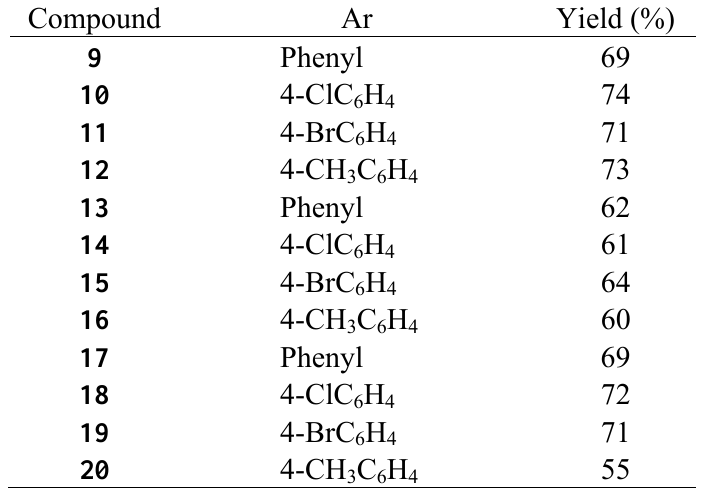
Table 2 . 4-Methylenenaphthoxazines 9-16 and spiro naphthoxazine dimmers 17-20 .